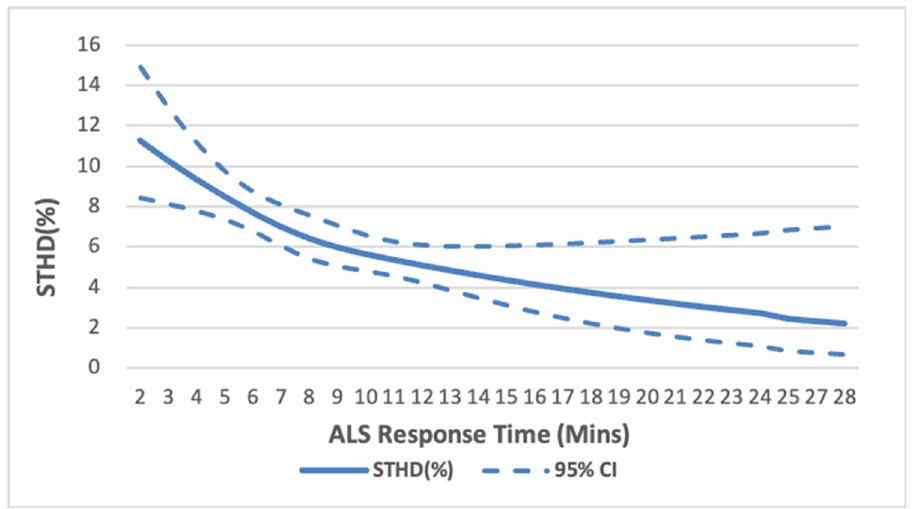
Fig 2. Spline curves for the outcomes of survival to hospital discharge (with 95% confidence intervals), as a function of ALS response time. Abbreviations: ALS = advanced life support. STHD = survival to hospital discharge.